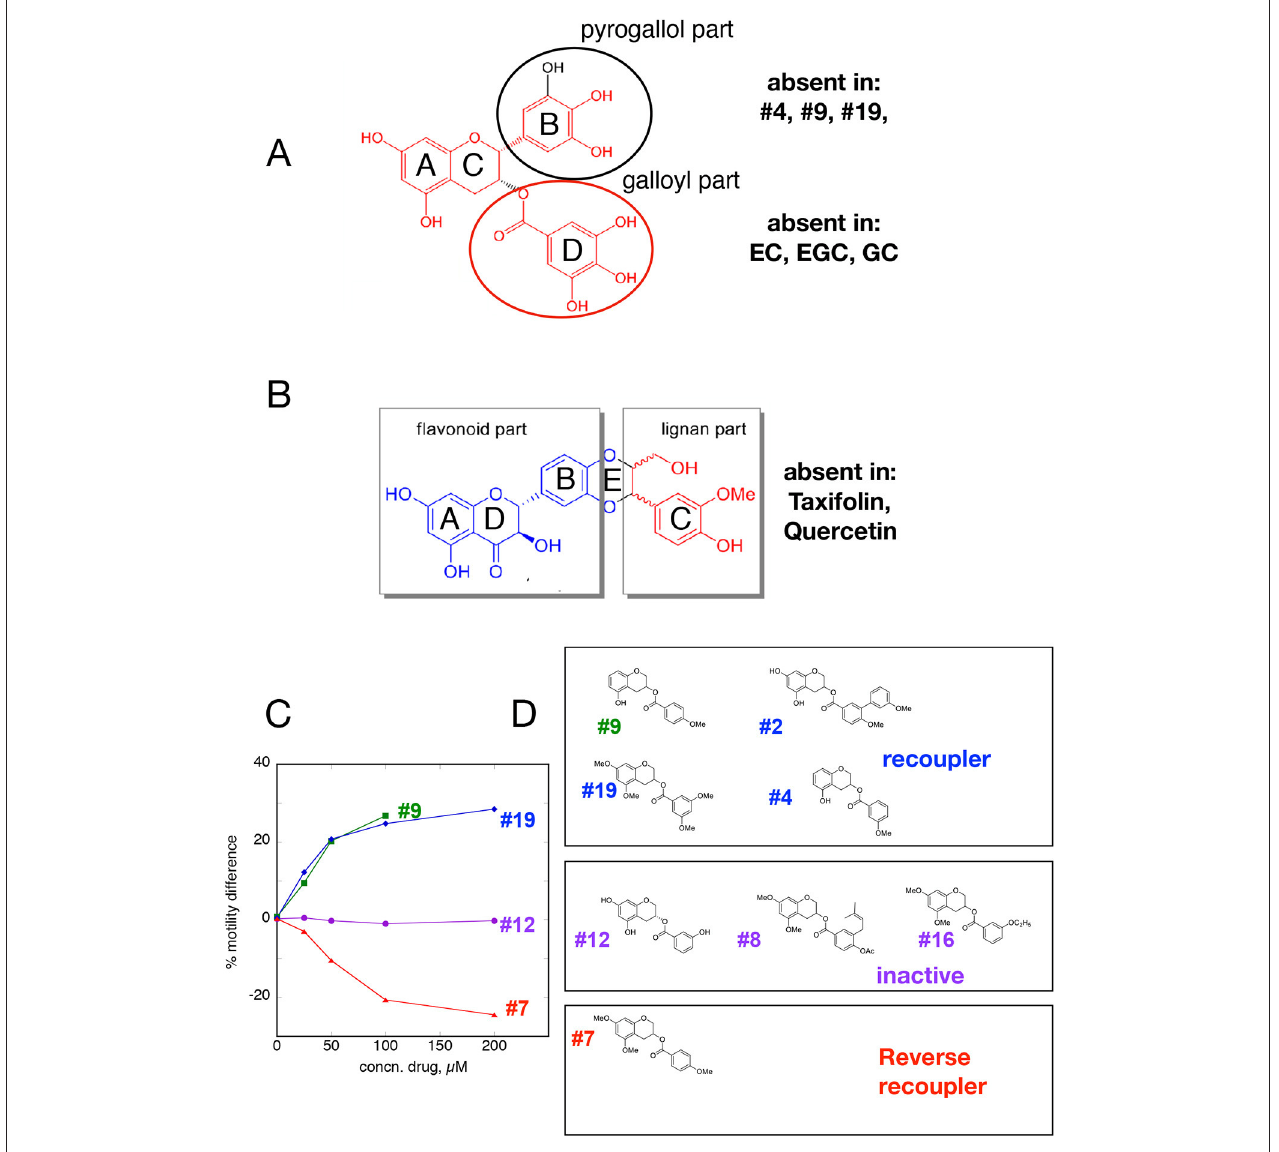
FIGURE 5 | Structure-function relationships (A,B) Minimal structures that re-couple. (C,D) Small changes in A and D ring of EGCG determine recoupling activity (C) , Dose-response curves for re-couplers #9 and #19, inactive compound #12 and reverse re-coupler #7. (D) Structures of related re-coupling, inactive, and reverse recoupling